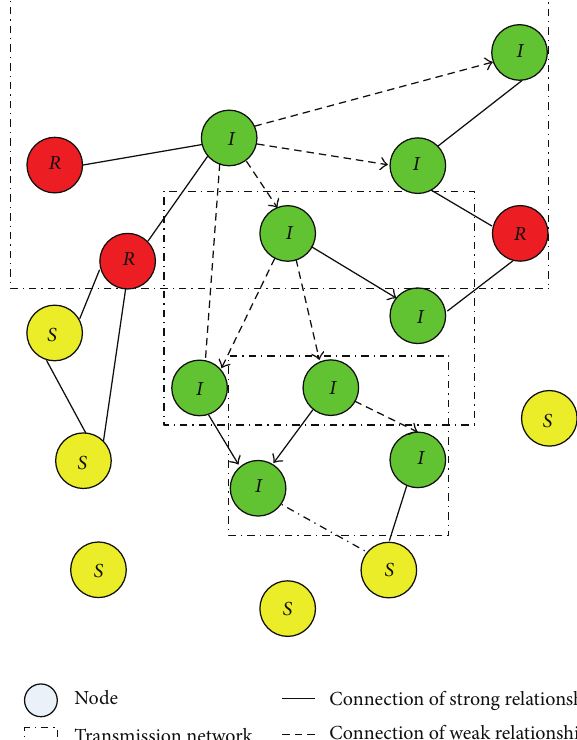
Figure 1: Evolution of nodes in process of information dissemina- tion.